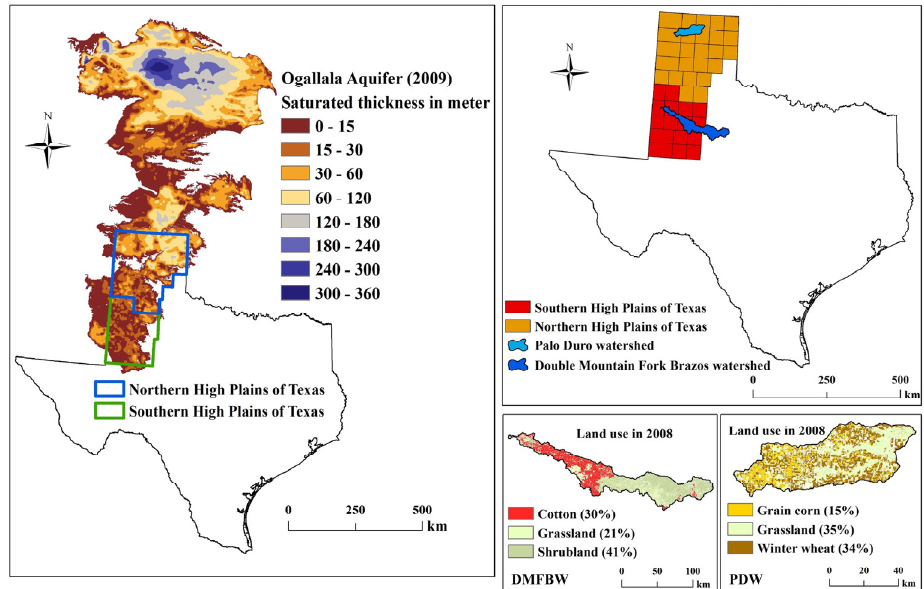
Figure 1. Saturated thickness of the Ogallala Aquifer and major land uses of two representative watersheds in the Northern and Southern High Plains of Texas.